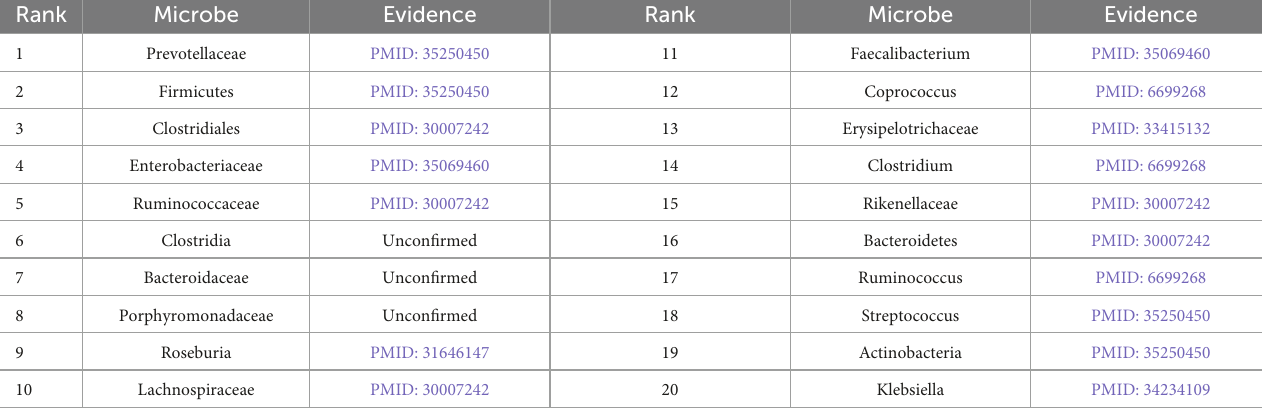
TABLE 6 Prediction results of top-20 epilepsy-related